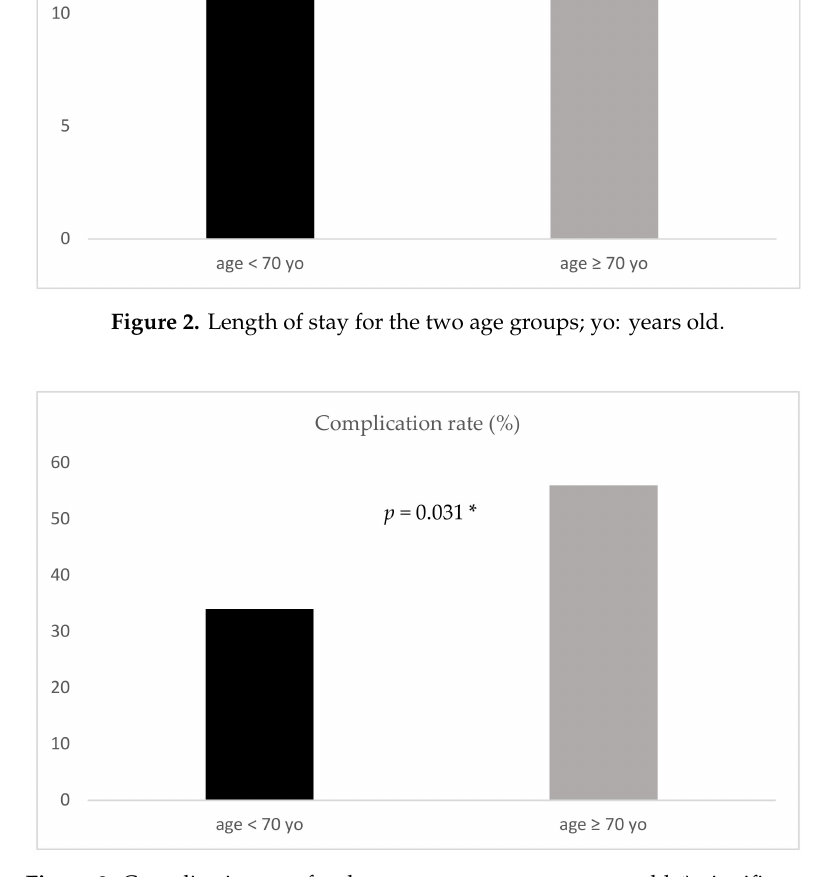
Figure 3. Complication rate for the two age groups; yo: years old; *: significant.